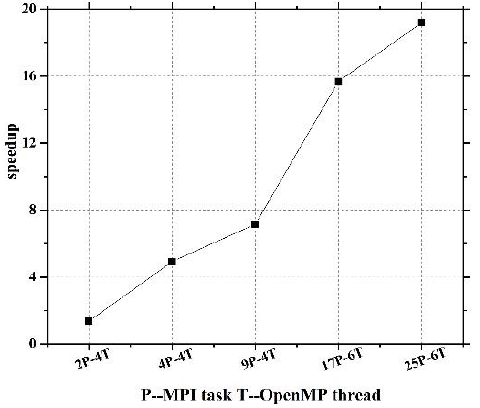
Figure 10. Speedup from different numbers of MPI tasks and OpenMP threads. As shown in Figure 11a, an ion density profile exists with a cavity depth of 15% near the reflection point. The absolute values of the vertical electric field | E z | and ion density perturbation ∆ N i are shown in Figure 11b,d, respectively, in the altitude range of 266.85 to 267 km at 1.5194 ms. For comparison, another case without an ion cavity, i.e., N cavity ( z )= 0, is shown in Figure 11c,e. The depth of the negative ion density cavity is related with the peak of the electrostatic field. Particularly, when a cavity was added near the reflection point, the depth of the negative ion density cavity and the peak of the electrostatic waves was greater than that in the case without a cavity.